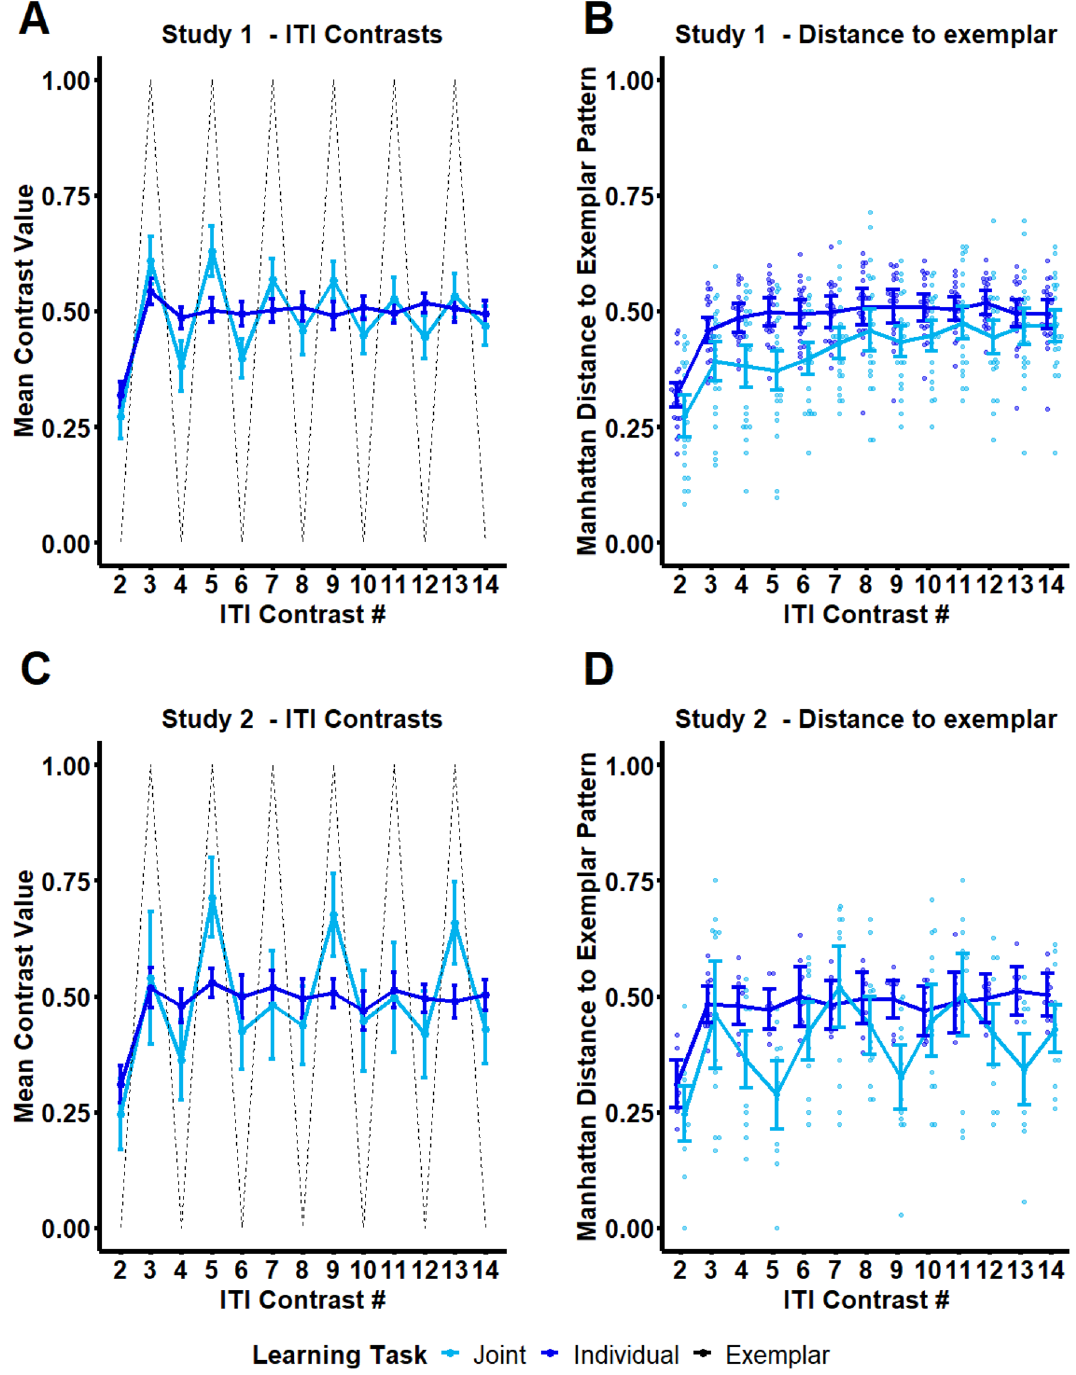
Figure 4. Illustration of study-specific rhythmic patterns. ITI contrast plots display patterns of durational change between successive ITIs, and clearly capture rhythmic patterns and changes in rhythmicity across ITIs in a sequence. The current figure displays mean ITI contrasts computed for Study 1 (Panel A) and Study 2 (Panel C) for Individual and Joint tasks, shown against an exemplar contrast pattern (black dotted line) representing perfect rhythmicity (negative lag-1 autocorrelation of 1.0). The mean geometric distance (Manhattan distance) to the exemplar at each ITI sequence position is also shown here for Study 1 (Panel B) and Study 2 (Panel C) to illustrate average changes in ITI rhythmicity over the course of a trial. Mean contrast values of .5 reflect no durational change between successive ITIs, mean contrast values above .5 reflect the same direction of durational change as the first pair of ITIs in the sequence, and values below .5 reflect the opposite direction of durational change as the first pair of ITIs. The figure clearly displays the enhanced rhythmicity of Joint relative to Individual ITI sequences in both studies, and that these rhythmicities depend upon turn-taking structure. Moreover, rhythmic patterns in Study 1 appear to change over time, reflecting within-trial learning. It should be noted that only ITI contrasts 2–14 are shown in each plot because the